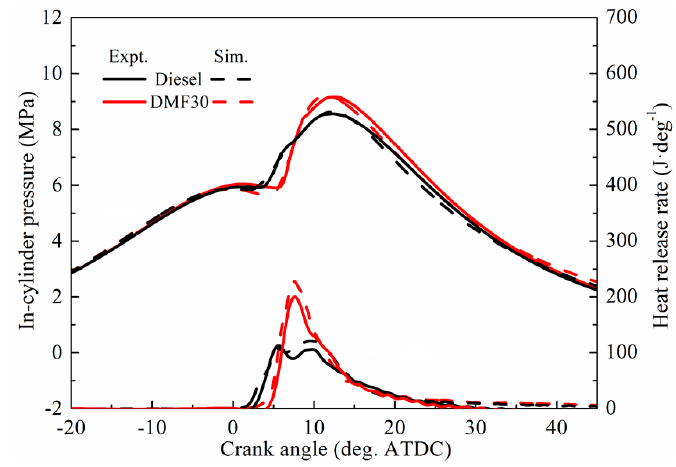
Figure 13. Measured and predicted in-cylinder pressure and HRR pro fi les.